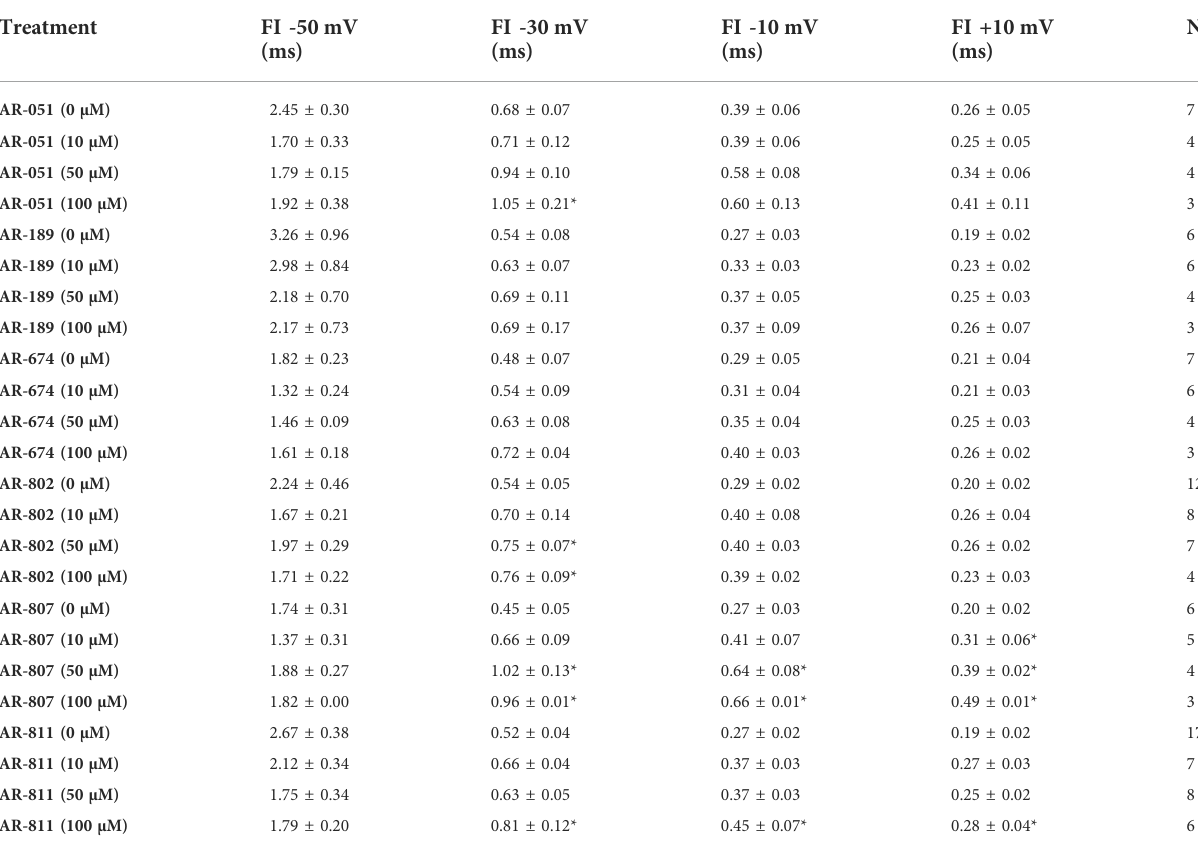
TABLE 5 Fast inactivation